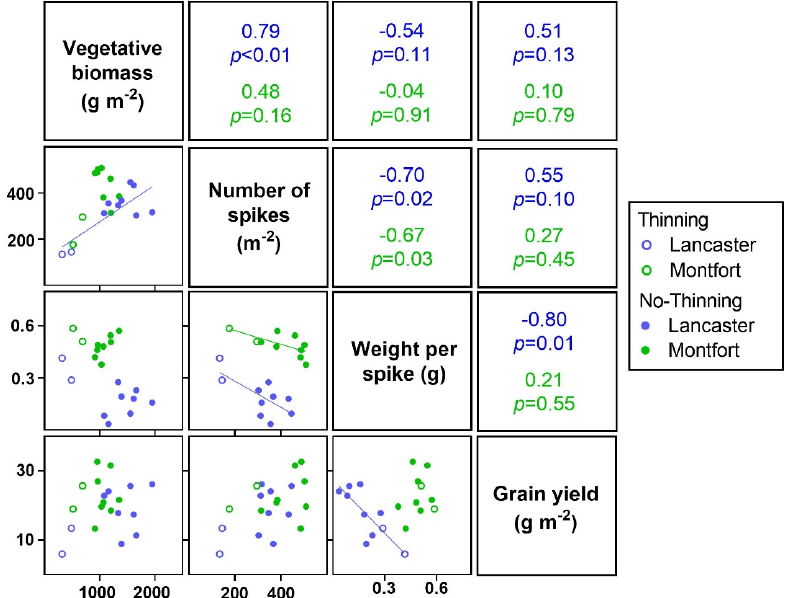
Figure 2. Correlation matrix plot with significance levels among the yield components per area. The lower triangular matrix is comprised of the bivariate scatter plots with a fitted line only when p < 0.05. The upper triangular matrix shows the Pearson correlation plus significance level ( p -values) in Lancaster (blue) or Montfort (green). In all the panels, each dot corresponds to the mean value of each treatment in Lancaster (blue dots) or Montfort (green dots). The treatments with mechanical or chemical thinning are showed as empty circles and all the other treatments as filled circles.